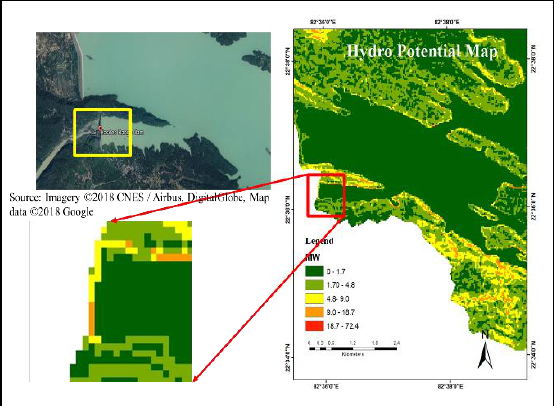
Figure 10. Hasdeo bango dam with hydro potential cell